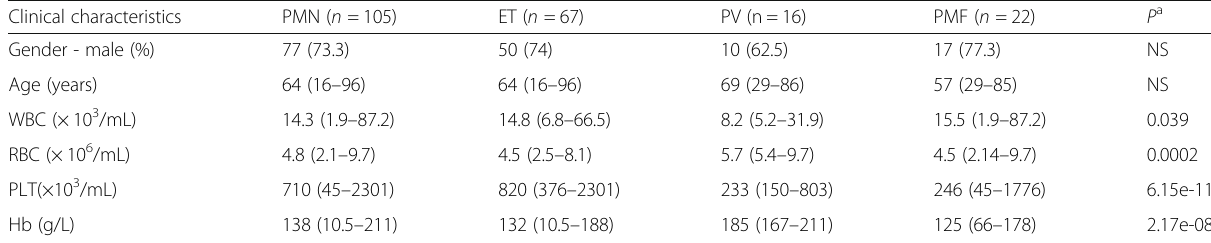
Table 1 Baseline characteristics of all PMN patients and subgroups classified into ET, PMF and PV syndrome Clinical